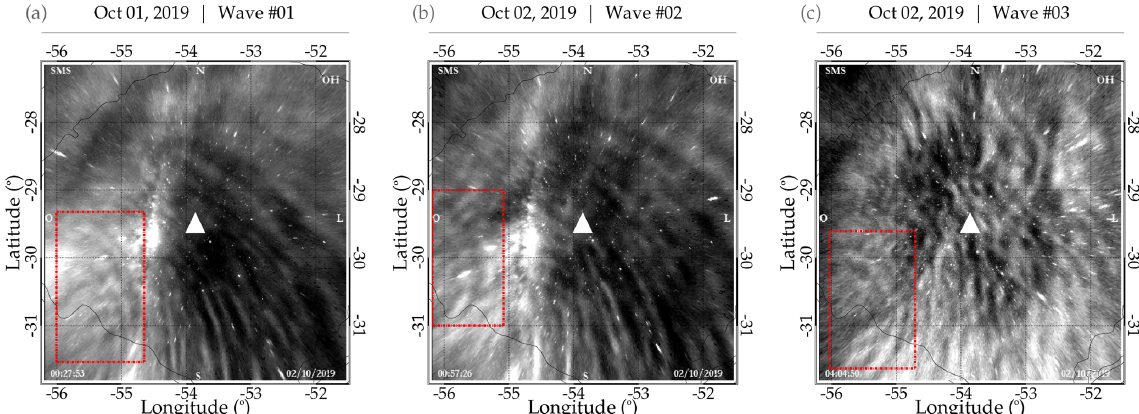
Figure 2. Sample of unwarped images of each concentric gravity wave (CGW) event observed at São Martinho da Serra on 1–2 October 2019. Panel (a) is Wave no. 01 at 00:27UT, panel (b) is Wave no. 02 at 00:57UT, and panel (c) is Wave no. 03 at 04:04UT. The white triangle shows the center of the image and the SMS observatory, while the red rectangles show the regions of the CGW events.